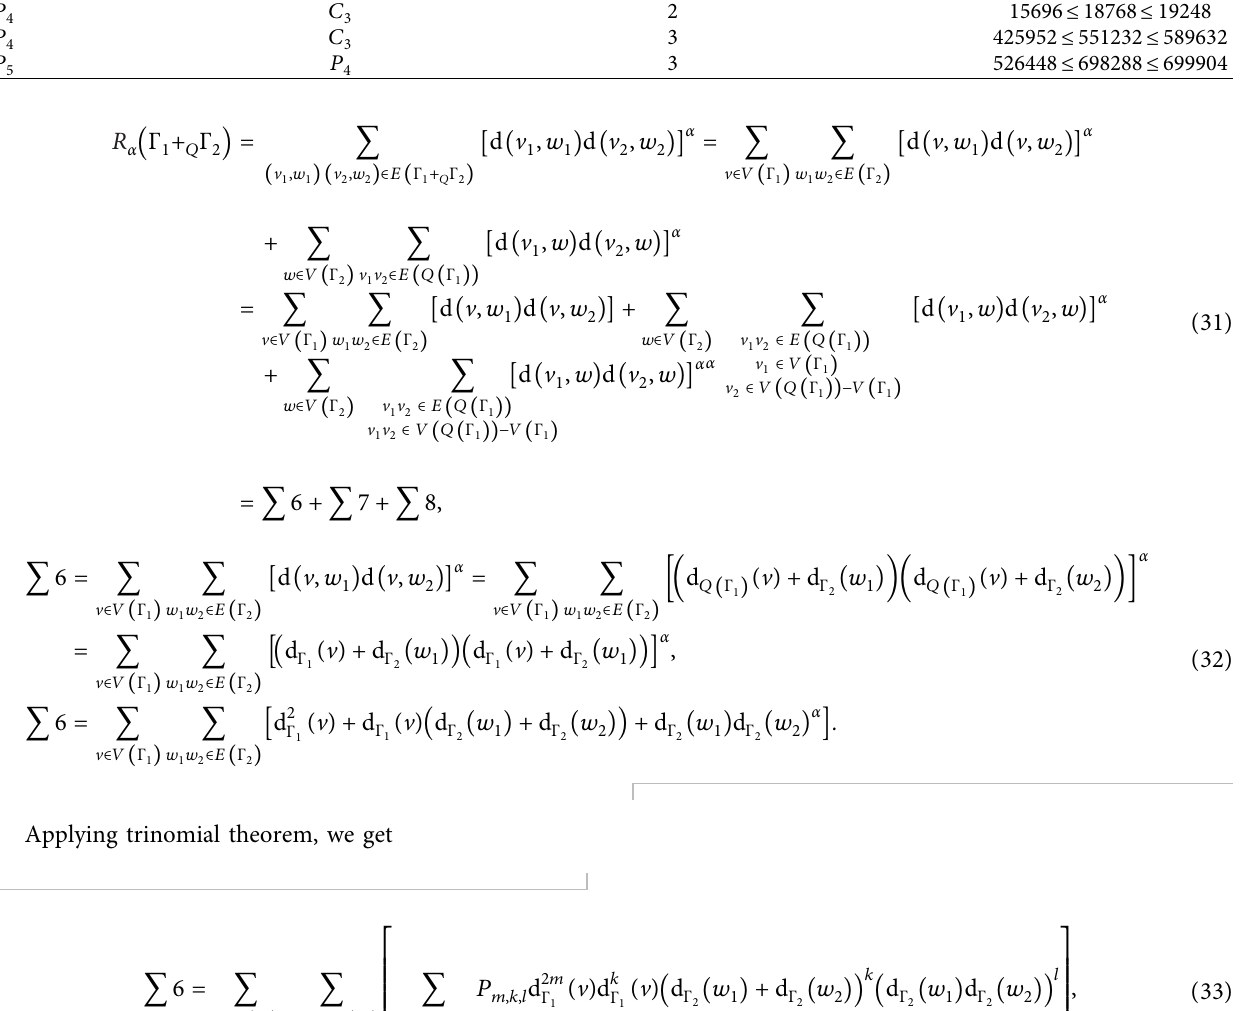
Table 5: Few more cases of lower and upper bounds regarding R